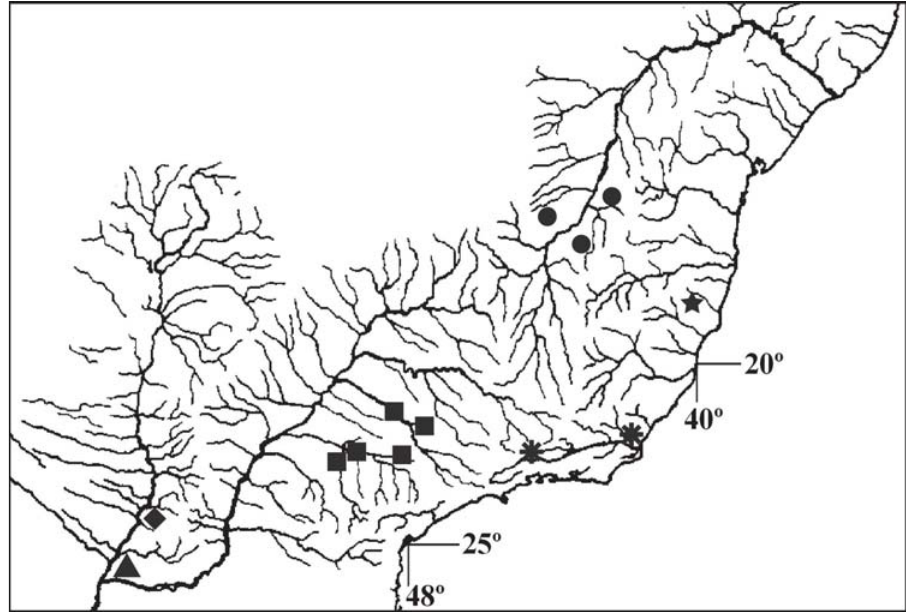
Fig. 3 . Partial map of South America showing the distribution of the Microglanis parahybae species complex. Microglanis carlae (diamond = type locality and triangle), M. garavelloi (square), M. parahybae (asterisk), M . pataxo (star) and M. leptostriatus (circle). A symbol may refer to more than one specimen